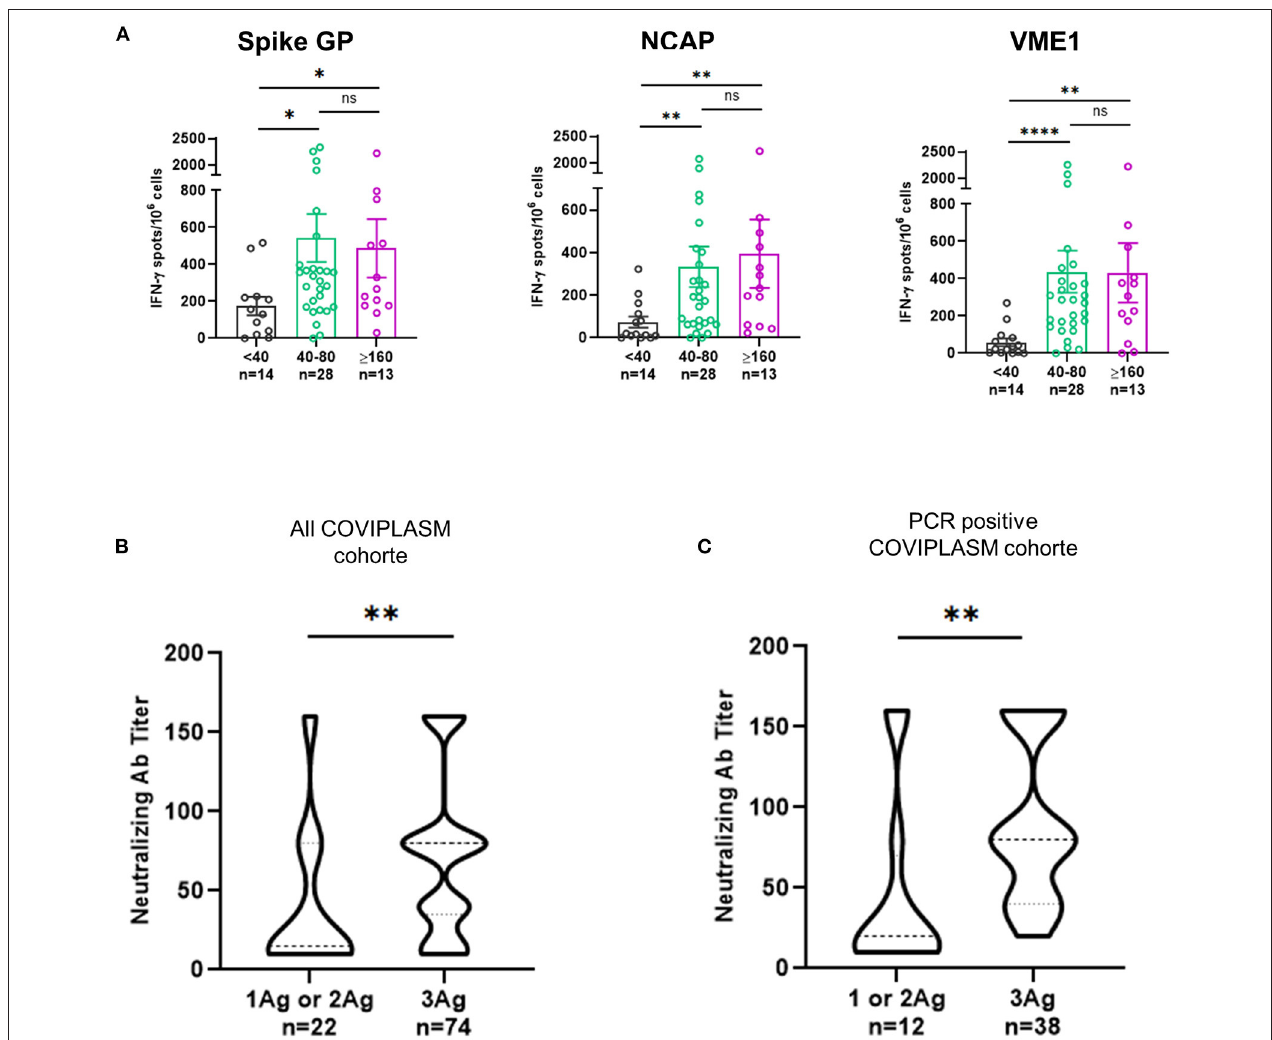
FIGURE 4 | T cell poly-specificity against SARS-CoV-2 derived proteins is highly correlated with neutralizing antibody titer of convalescent plasma donors. (A) Magnitude of IFN- γ + SARS-CoV-2-S, VME1 and NCAP T cell responses according to neutralizing antibody titers in PCR positive CPD. (B) Neutralizing antibody titers for responses against one or two and three peptides derived SARS-CoV-2 proteins in all CPD. (C) Neutralizing antibody titers for responses against one or two and three peptides derived SARS-CoV-2 proteins in PCR positive CPD. Ag, antigen; CPD, convalescent plasma donor; GP, glycoprotein; NCAP, nucleocapsid; VME1, membrane protein. * p < 0.05, ** p < 0.01, *** p < <0.001, **** p <